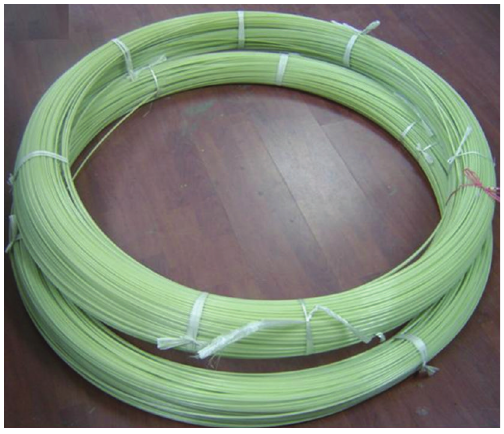
Figure 1: Finished product of FRP-OF